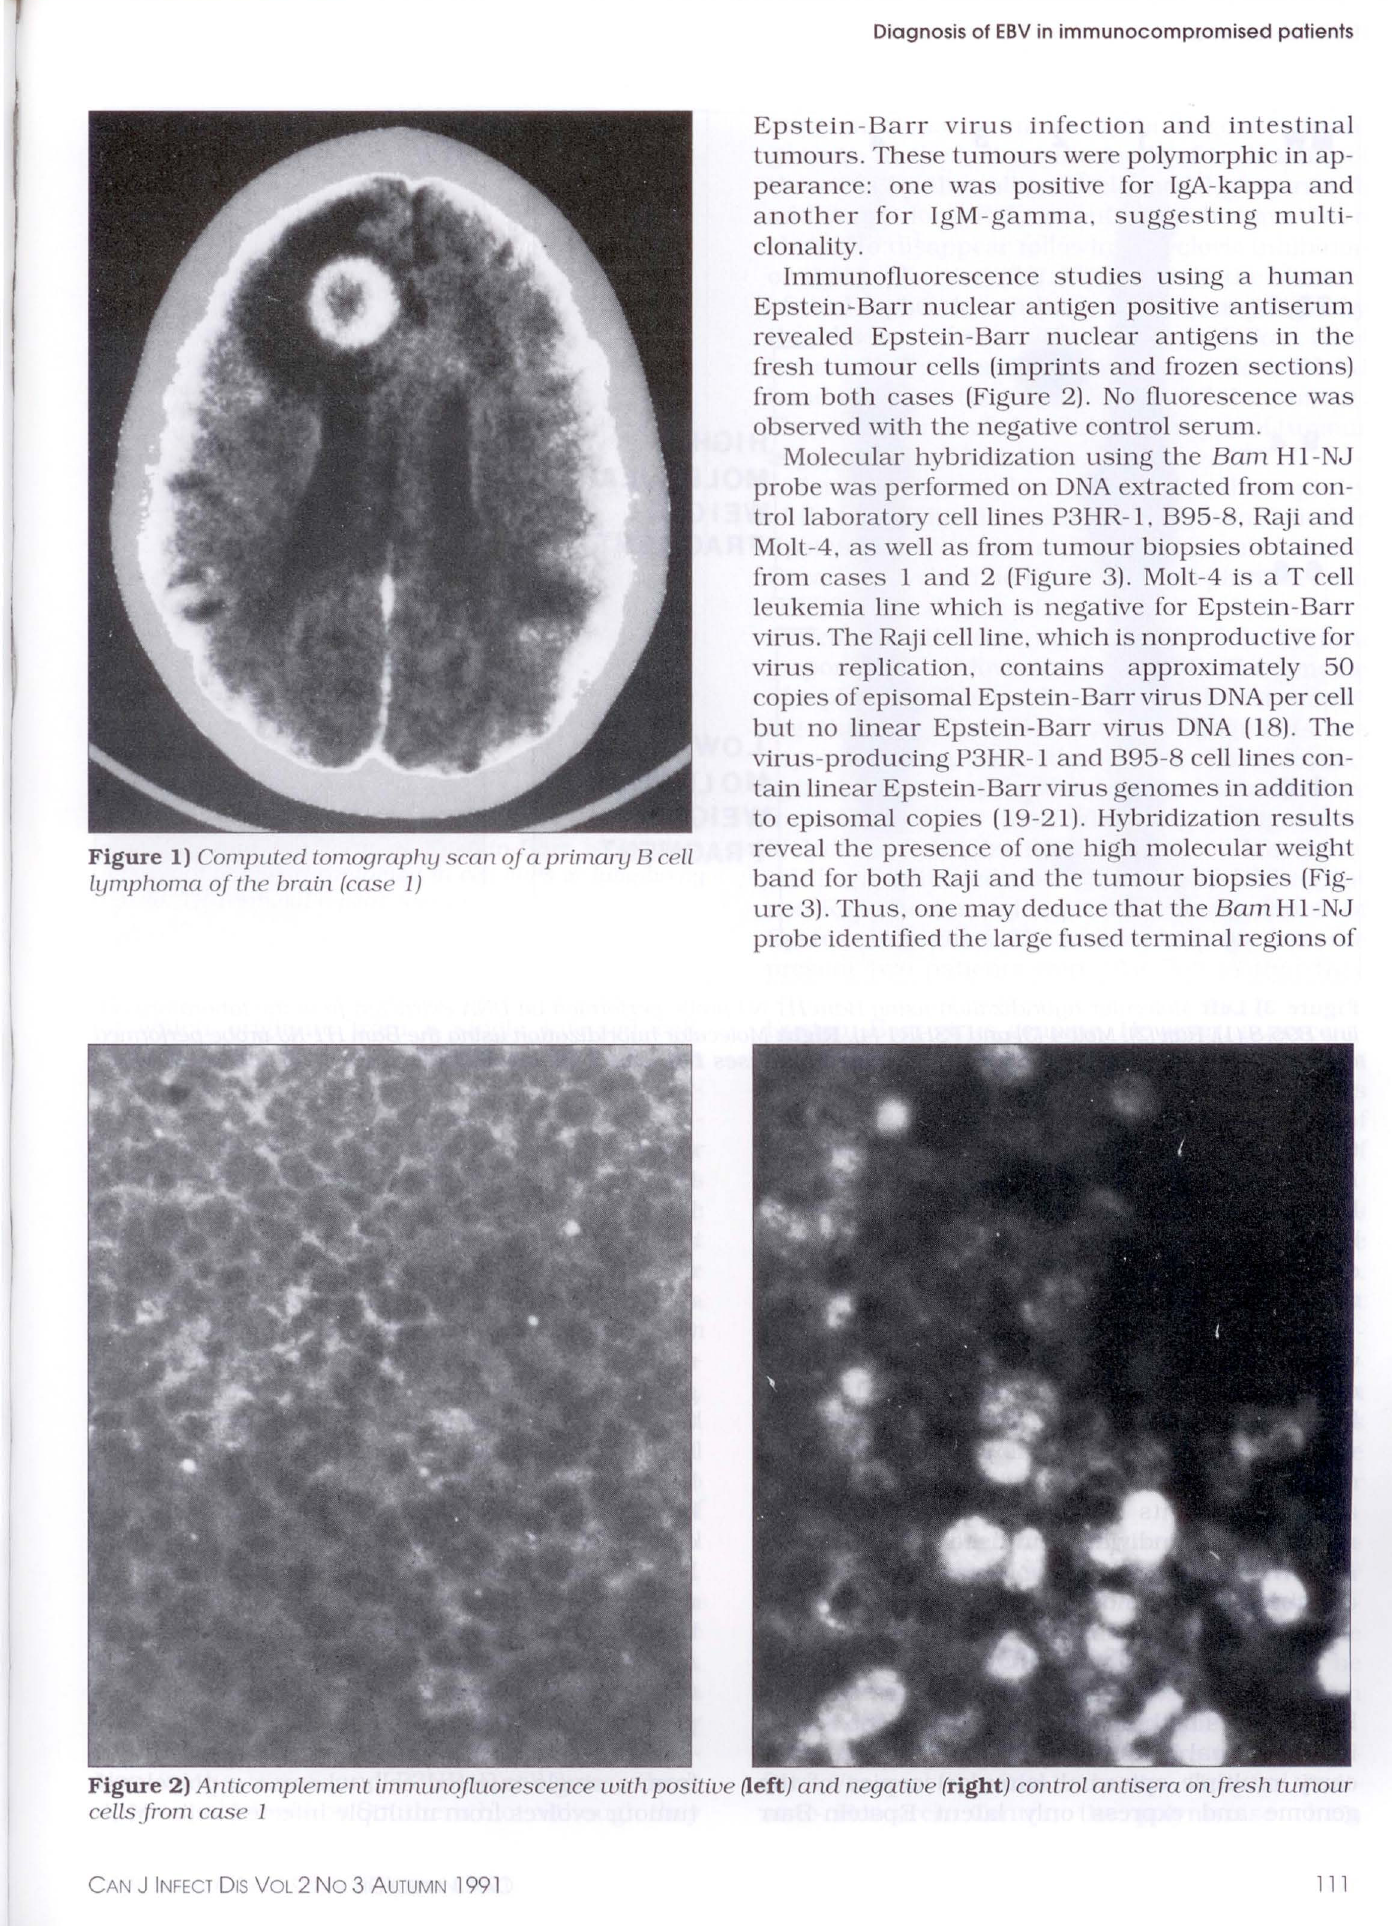
Figure 2) Anticomplement immunofluorescence with positive {left) and negative (right) control antisera onjres/1 tumour cells from case